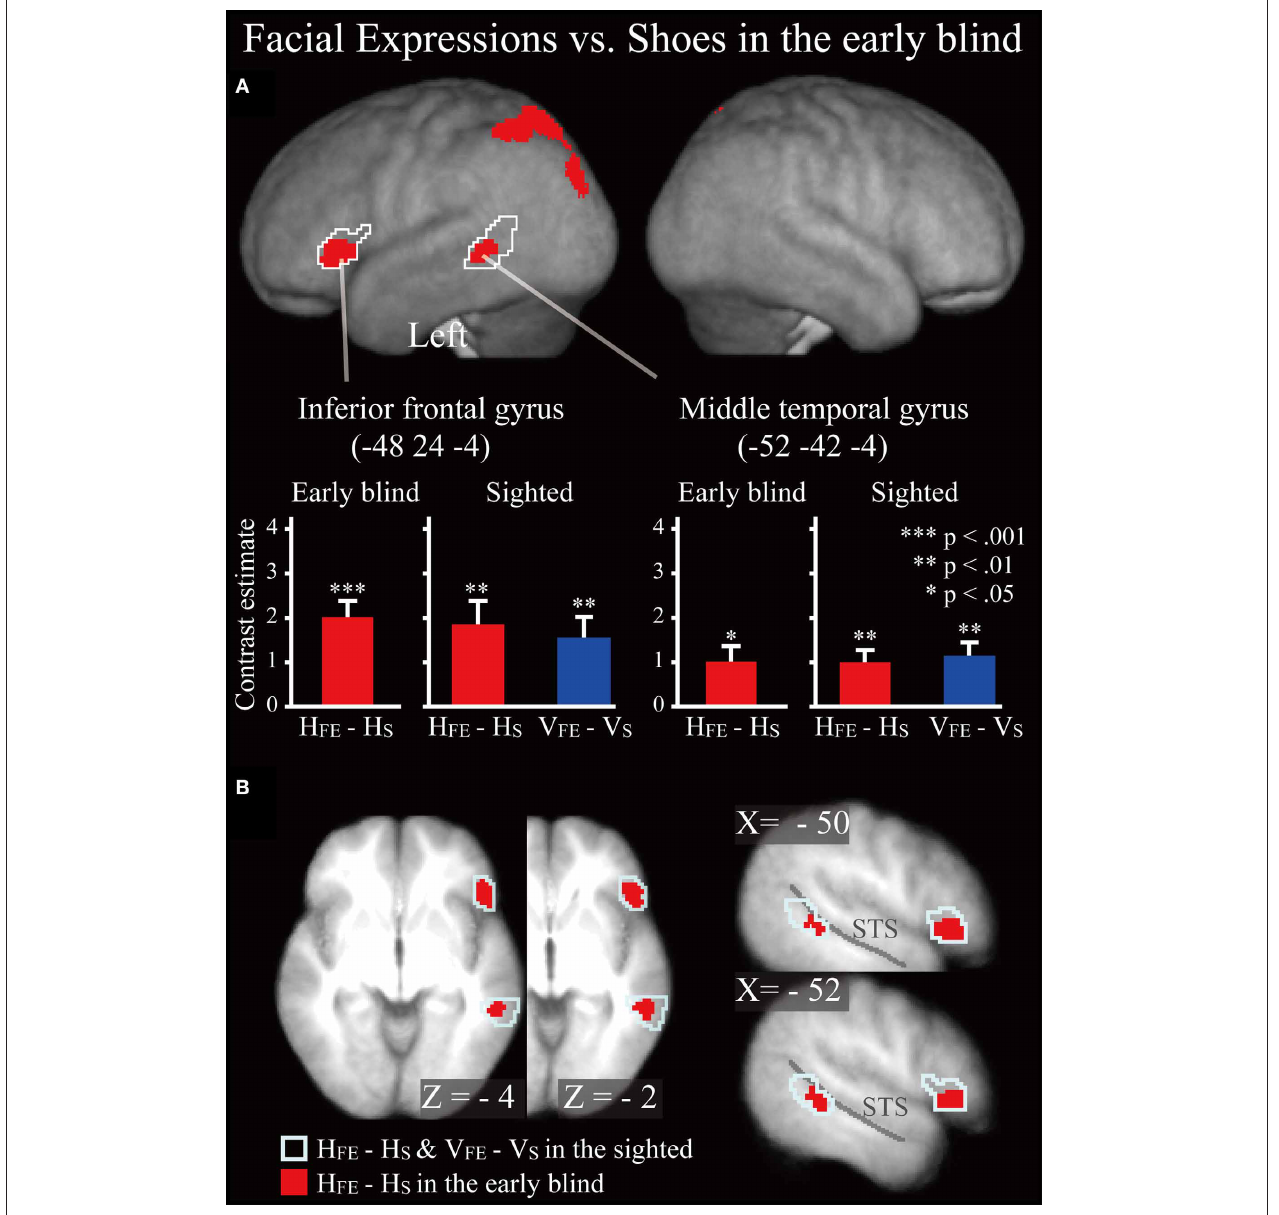
FIGURE 6 | SPM of the average neural activity within the early blind group during haptic identification of facial expressions compared with shoes ( H FE − H S ). (A) The activation patterns were superimposed on a surface-rendered T1-weighted high-resolution MRI averaged across the subjects. The white lines indicate regions activated during haptic and visual recognition in the sighted group (see Figure 5B ). The bar graphs indicate the contrast estimates (i.e., activity) for identification of facial expressions relative